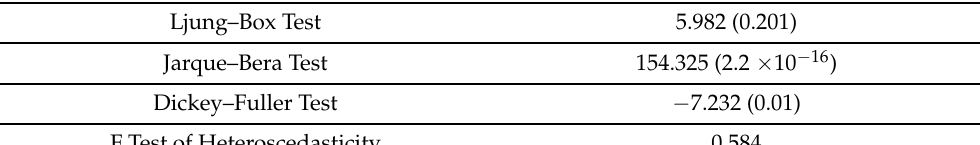
Table 5. Diagnostic test of standardized residuals: Ljung–Box Test; Jarque–Bera Test; Dickey–Fuller Test; and F Test of Heteroscedasticity.